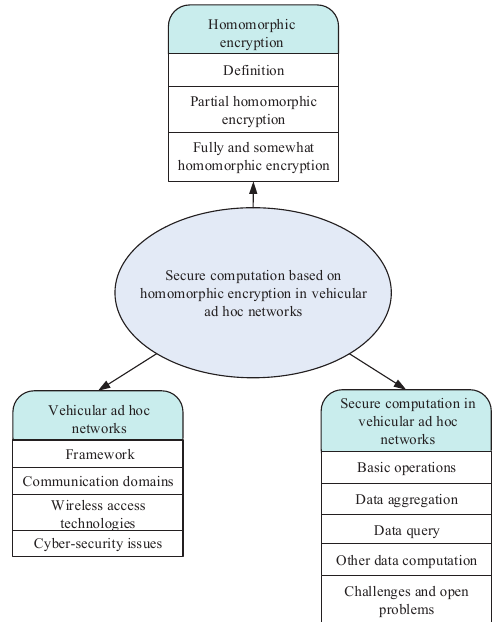
Figure 1. The road map of secure computation based on homomorphic encryption in vehicular ad hoc